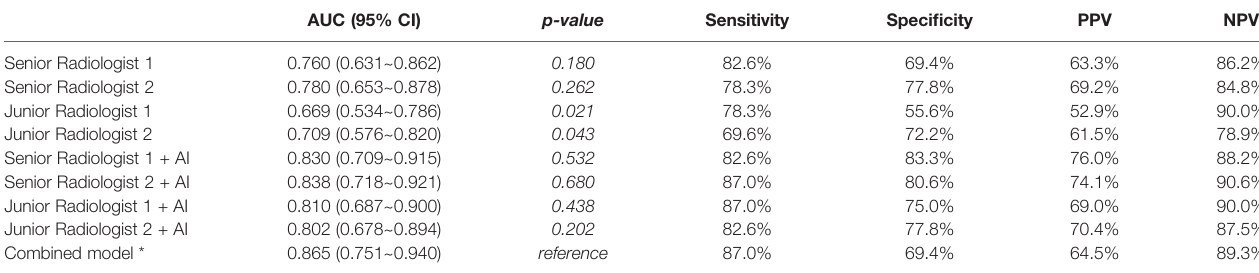
TABLE 4 | Comparison of the diagnostic ef fi ciency between the Combined model and the radiologists (with or without AI assistance) in the independent testing